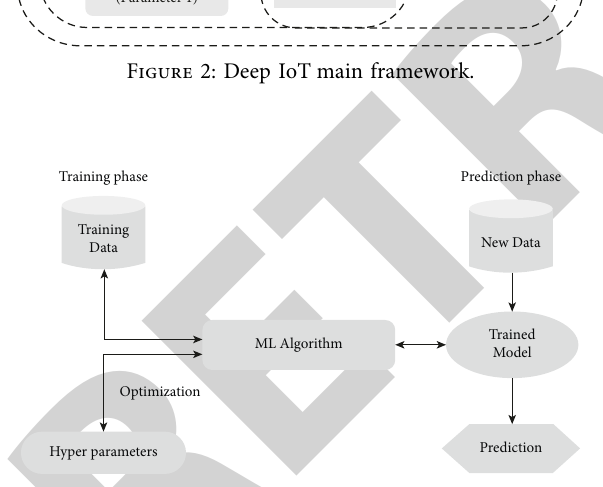
Figure 3: General machine learning overview.